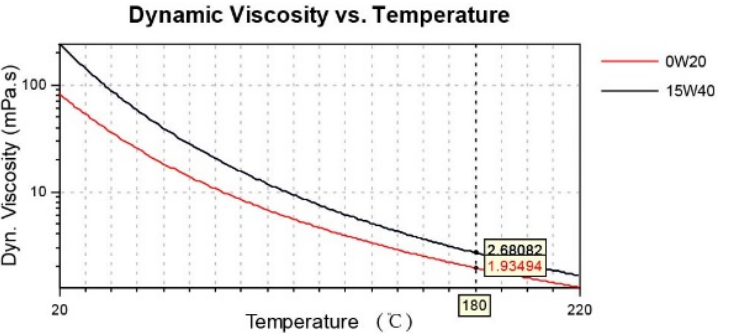
Figure 5. Comparison of viscosity temperature relationship between SAE 15W40 and SAE 0W20 standard oils.